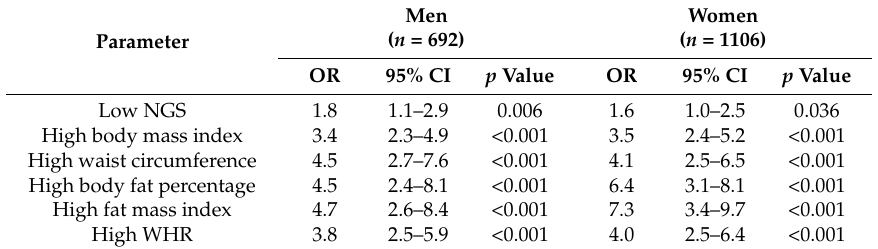
Table 2. Associations between fitness and fatness parameters with high cardio-metabolic risk. Parameter